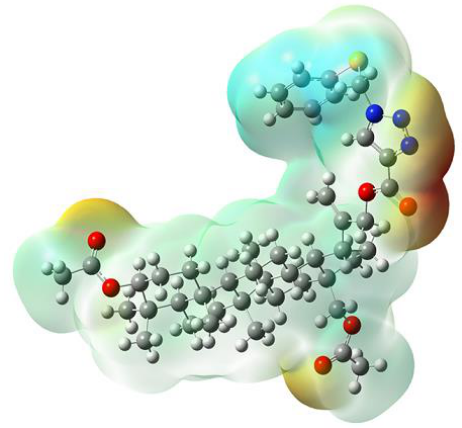
Figure 8. Molecular electrostatic potential (MEP) map for 4 .